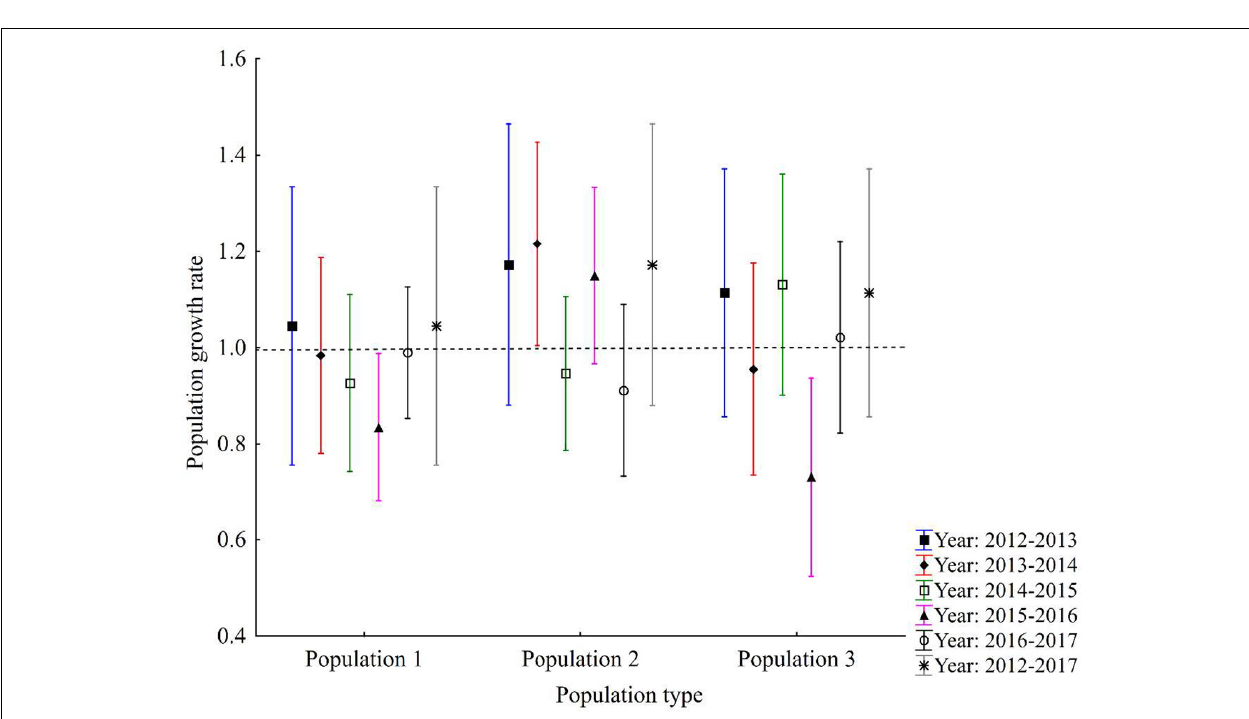
FIGURE 3 | Population growth rates and their 95% confidence intervals for three populations. The last value for each population (indicated by asterisks) shows stochastic population growth rate for all transition intervals combined (2012–2017). Dashed line ( λ = 1) indicates a stable population.